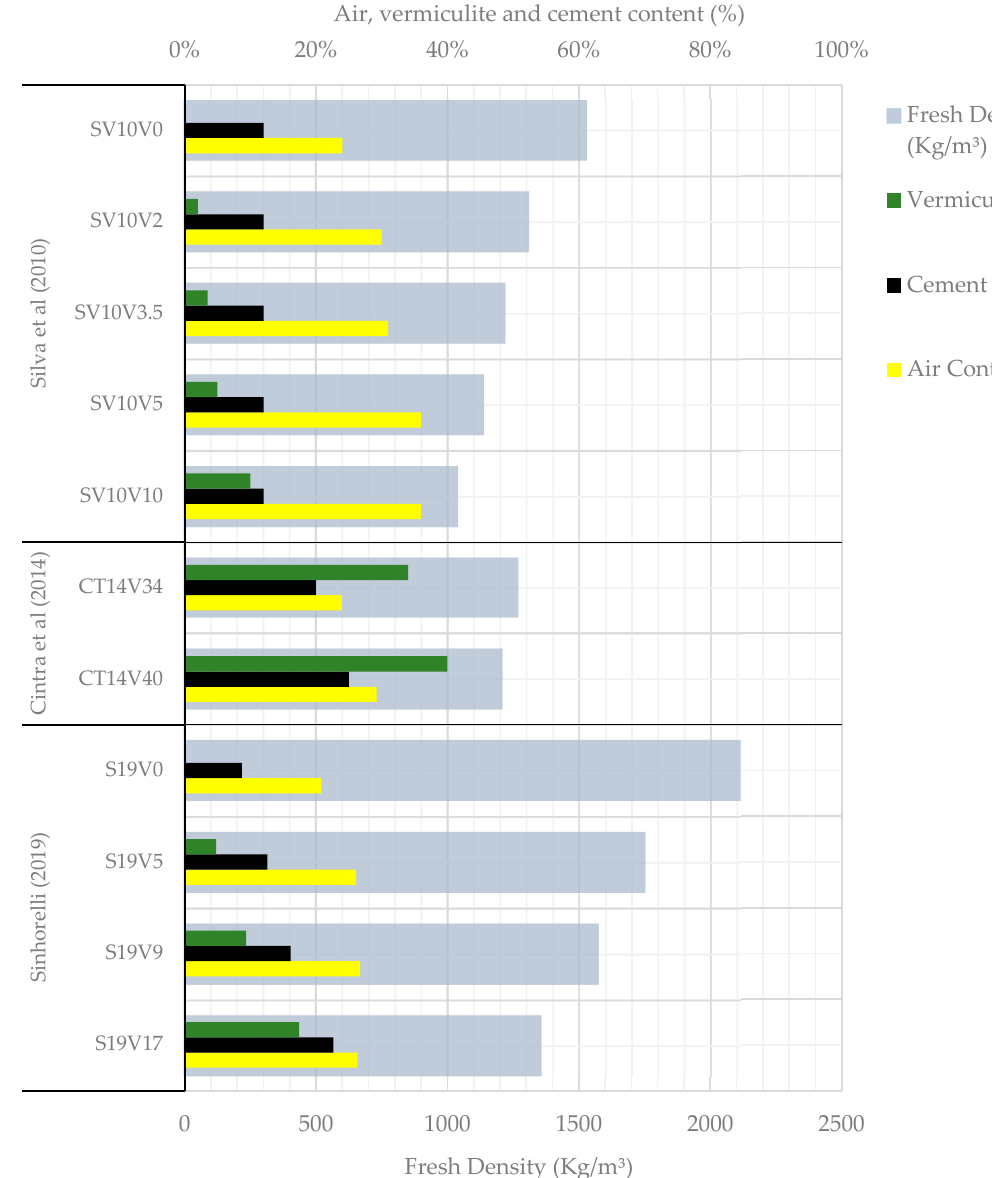
Figure 6. Correlation of the fresh density, air content, cement, and vermiculite [41,43,45].